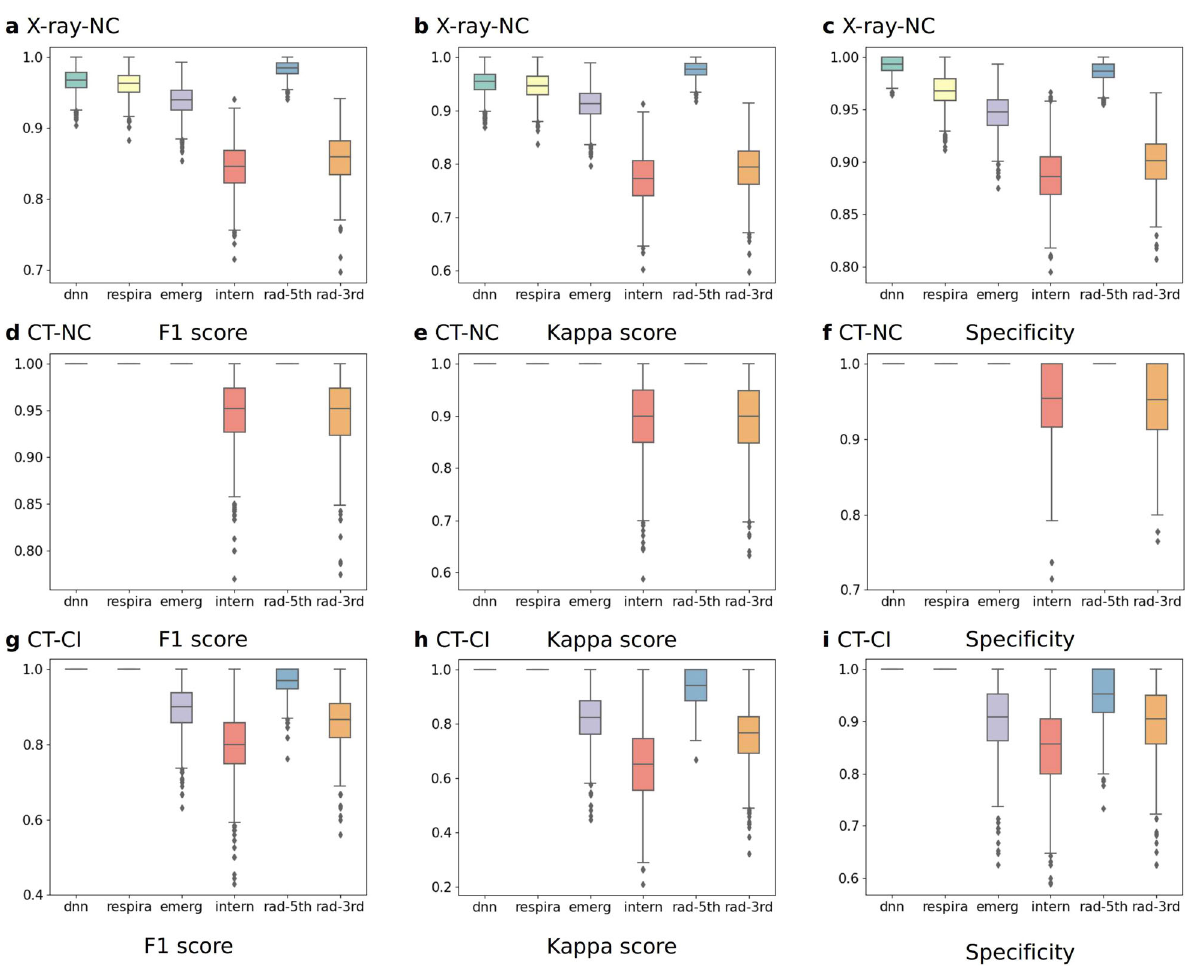
Fig. 5 Boxplots of the F1 score, kappa score, and speci fi city for the CNNCF and expert results for COVID-19 identi fi cation. NC indicates that the positive case is a COVID-19 case, and the negative case is *Normal. CI indicates that the positive case is COVID-19, and the negative case is in fl uenza. Bootstrapping is used to generate n = 1000 resampled independent validation sets for the XVS and the CTVS. a F1 score for the NC using X-data. b Kappa score for the NC using X-data. c Speci fi city for the NC using X-data. d F1 score for the NC using CT-data. e Kappa score for the NC using CT-data. f Speci fi city for the NC using CT-data. g F1 score for the CI using CT-data. h Kappa score for the CI using CT-data. i Speci fi city for the CI using